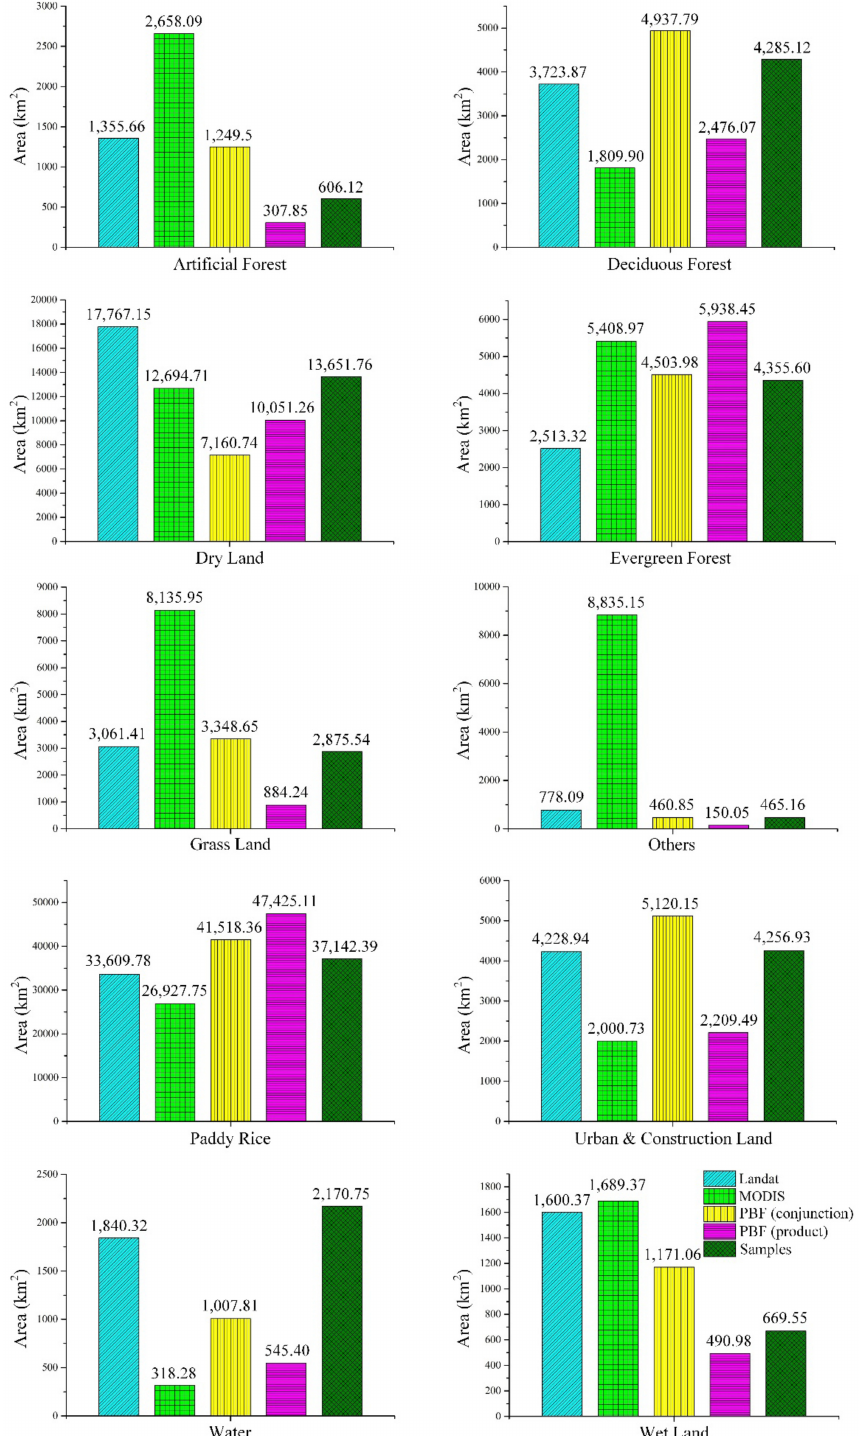
Figure 19. Comparison of the estimated area for each land types derived from the samples, Landsat data, MODIS, and two PBF methods (respectively, with conjunction and product) in the Mun River